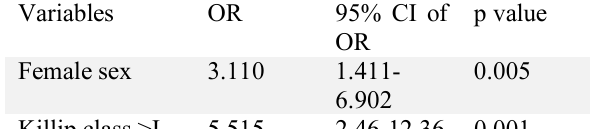
Table 2: Univariate analysis of different variables